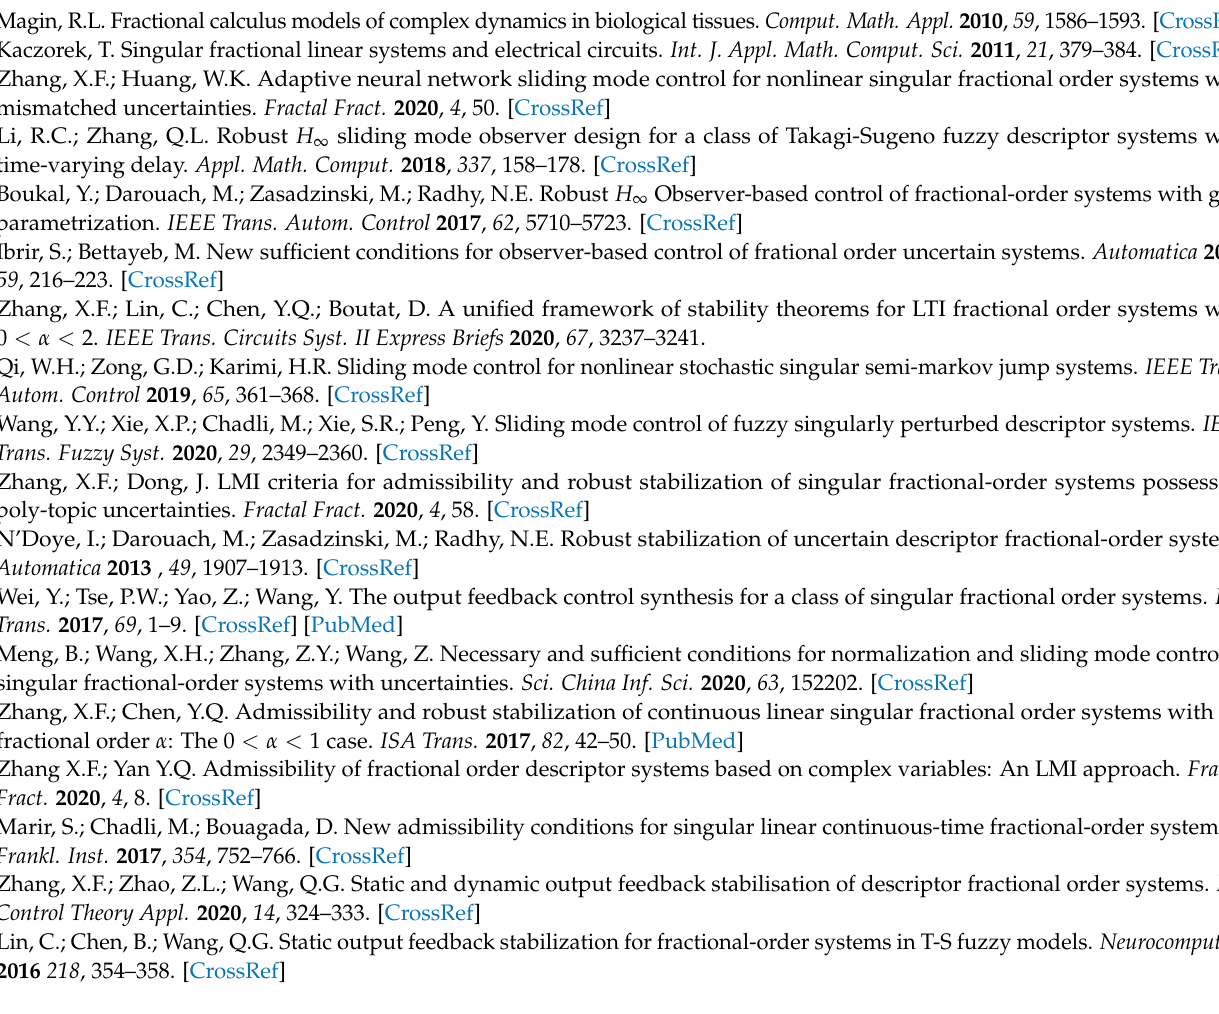
Figure A2. Fractional-order model.